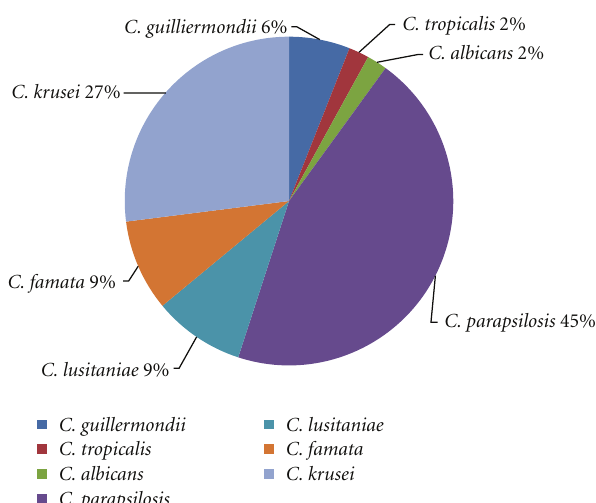
Figure 3: Proportion of Candida species isolated from milk samples of cows su ff ering from mastitis.